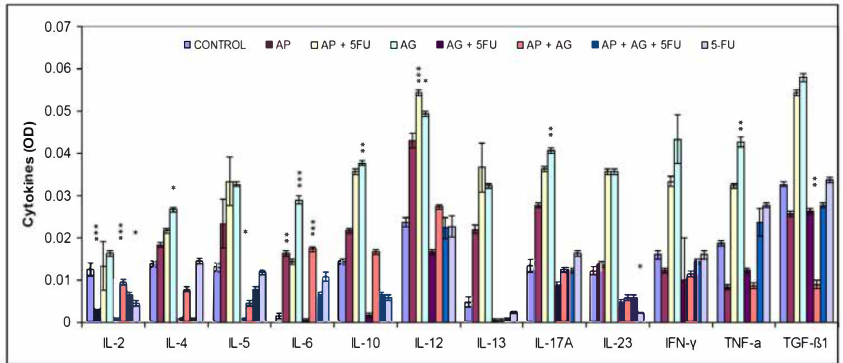
Figure 4. E ff ect of treatment with Agarikon Plus, Agarikon.1 and 5-fluorouracil in various combinations on cytokine levels in serum supernatant of mice bearing CT26.WT tumors. Mice were sacrificed on the 28th day and cytokine level in serum supernatant was measured by ELISA kit according to the manufacturer’s instructions (Multi-Analyte ELISArray kit, Qiagen) for mouse. * Significantly di ff erent (* p < 0.05; ** p < 0.01; *** p < 0.001) in comparison with control group. Data (mean ± SD) shown are from one representative experiment, with n = 3 per treatment